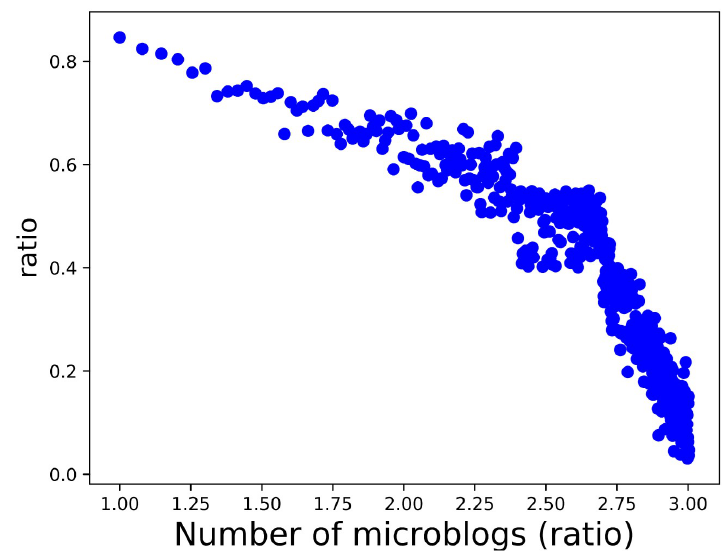
Figure 11. The distribution of a reposting number of the microblog data set.